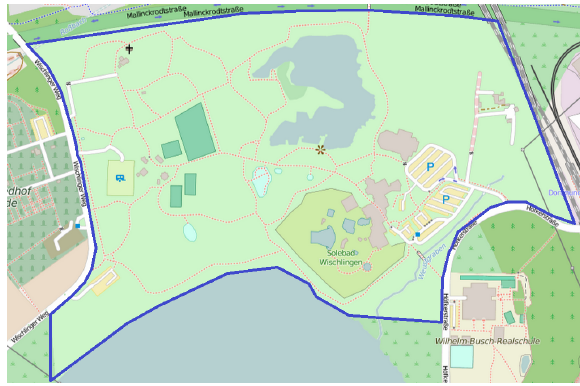
Figure 5: An entity with osm id = 25422214 Rule conf Class ( X, ” park ”) ← contains ( X, [1 , 15 , 27 , 89]) 94% Class ( X, ” park ”) ← contains ( X, [1 , 15 , 21 , 22]) Class ( X, ” park ”) ← meet ( X, [6 , 15]) 70% where 1= leisure playground , 6= highway residential , 15= highway footway , 21= sport soccer , 22= leisure pitch , 27= building yes and 89= nature water Table 1: Matched rules for the entity with osm id = 25422214